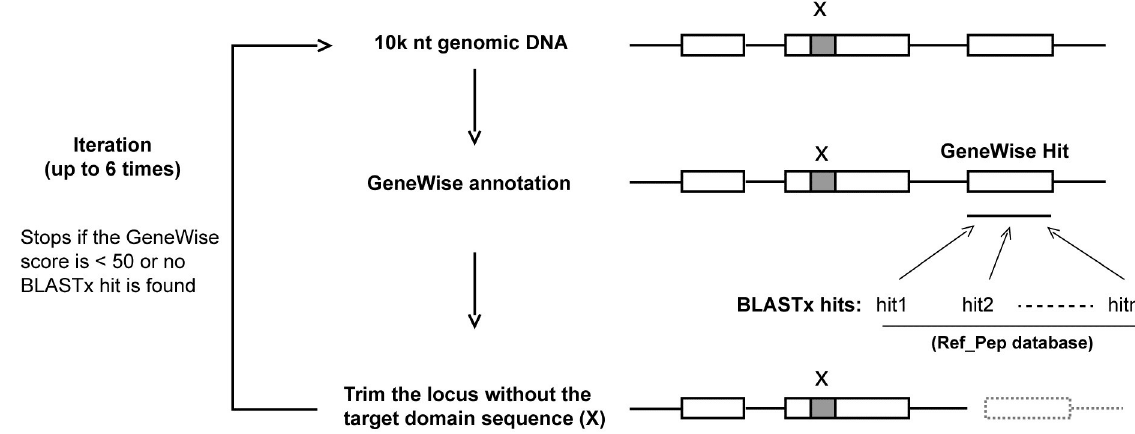
Fig 1. A schematic illustration of the CTT algorithm. The "x" indicates a genomic region that encodes a target family domain. The coordinates of “x” is defined by a tBLASTn search using the query of seed sequences of the target family. "Hit1, 2, ... n" indicate the top hits from a BLASTx search using a 10,000 nt genomic DNA sequence containing “x” as query against protein sequences of previously-annotated family members. The process is iterated for up to six times to shorten the genomic sequence until a new locus containing “x” is discovered. The iteration stops if the GeneWise score is lower than 50 or no BLASTx hit is